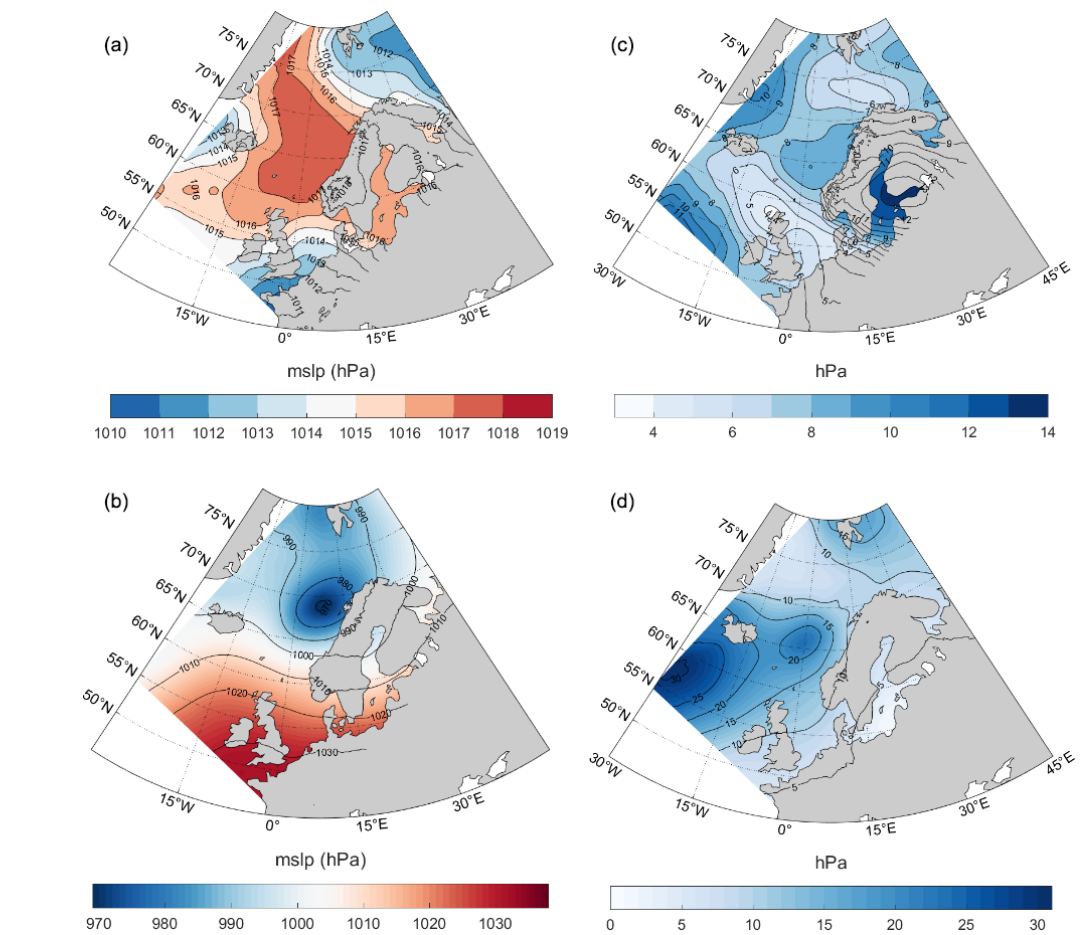
Figure 12. Same as in Fig. 11, but for the site pair Draugen + Norne (dr +